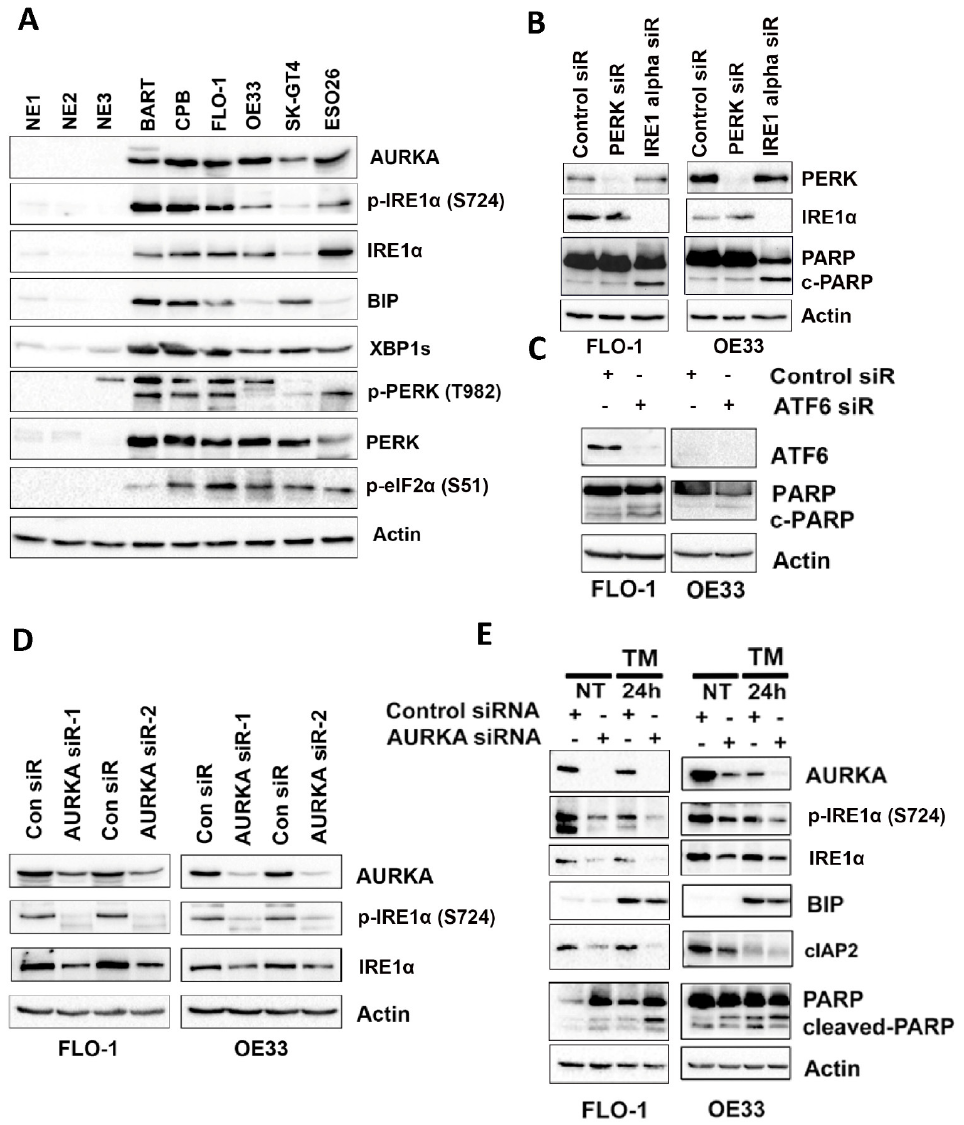
Figure 2. IRE1α promotes cancer cell survival dependent on AURKA in EAC. ( A ) Western blot analysis of AURKA, p-IRE1α (S724), IRE1α, BIP, XBP1s, p-PERK (T982), PERK, p-eIF2α (S51), and β-actin protein expression in the normal esophagus (NE), BART, CPB, FLO-1, OE33, SK-GT4, and ESO26 cells. ( B ) Western blot analysis of PERK, IRE1α, PARP, cleaved-PARP (c-PARP), and β-actin protein expression in FLO-1, OE33 cells at 72 h after control siRNA, PERK siRNA, or IRE1α siRNA transfection. ( C ) Western blot analysis of ATF6, PARP, cleaved-PARP (c-PARP), and β-actin protein expression in FLO-1 and OE33 cells at 72 h after control siRNA or AFT6 siRNA transfection. ( D ) Western blot analysis of AURKA, p-IRE1 α (S724) IRE1 α , and β -actin protein expression in FLO-1 and OE33 cells at 72 h after control siRNA, AURKA siRNA-1, or AURKA siRNA-2 transfection. ( E ) Western blot analysis of AURKA, p-IRE1 α (S724), IRE1 α , cIAP2, BIP, PARP, cleaved-PARP (c- PARP), and β -actin protein expression in FLO-1 and OE33 cells at 72 h after control or AURKA siRNA transfection with or without tunicamycin (TM) 10 µ g/mL treatment for the last 24 h after